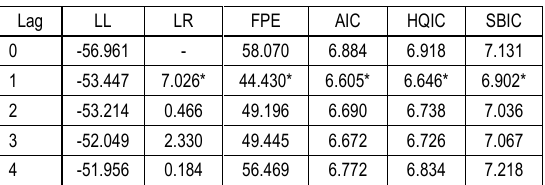
Table 6. The results of the VAR-test for identification of the optimal structure of time lags